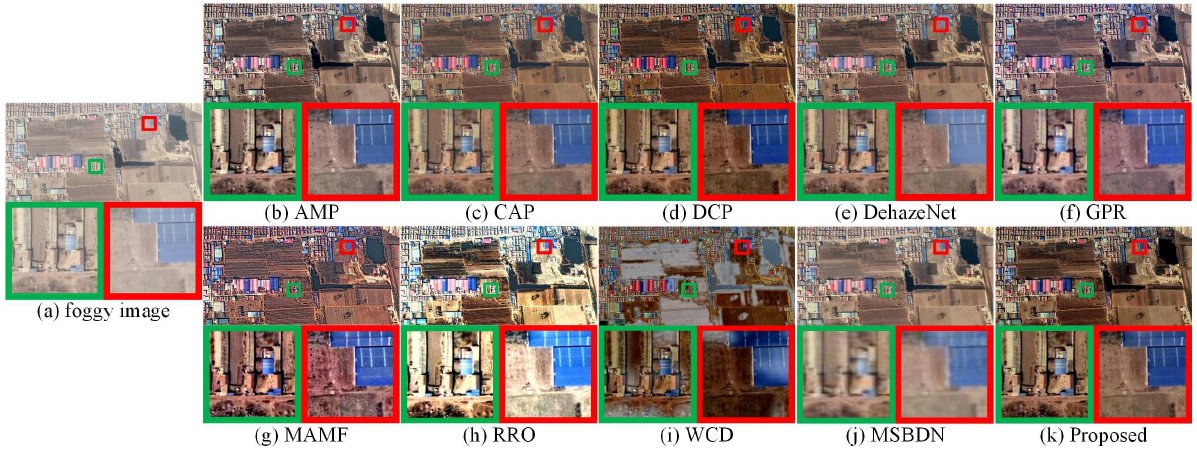
Figure 5. ( a ) shows a real-world foggy remote sensing image. ( b – k ) respectively represent the defogged images obtained by AMP, CAP, DCP, DehazeNet, GPR, MAMF, RRO, WCD, MSBDN, and the proposed method. The two partially enlarged images marked in the green and red frames correspond to two areas enclosed by the green and red frames in each defogged